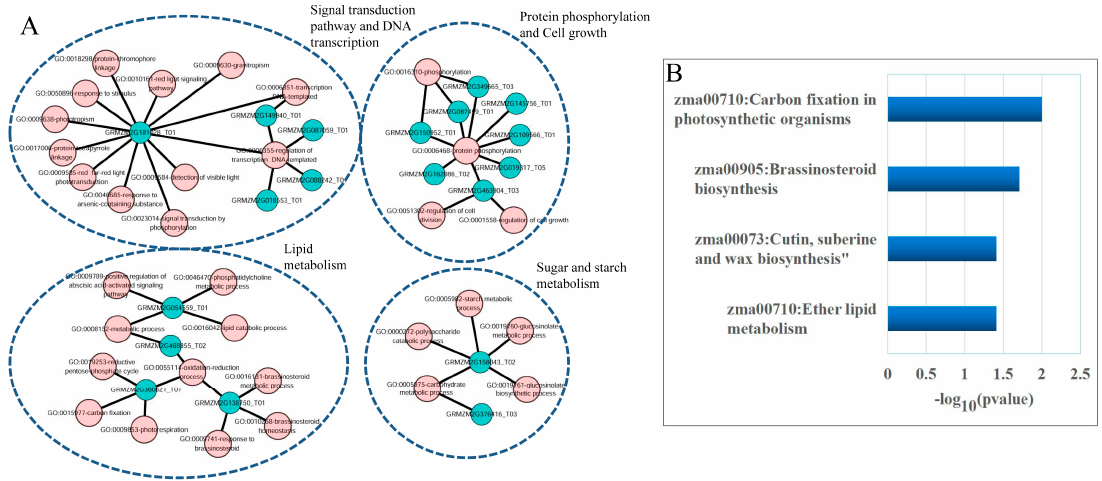
Figure 7. Functional analysis of the deregulated lncRNAs. ( A ) Functional enrichment map of gene ontology (GO) terms for mRNAs as ceRNA counterparts of lncRNAs. Each pink node represents a GO term and each blue node represents the proportion of shared genes between connecting GO terms; ( B ) The enriched Kyoto Encyclopedia of Genes (KEGG) pathways ranked by –log 10 ( p value).